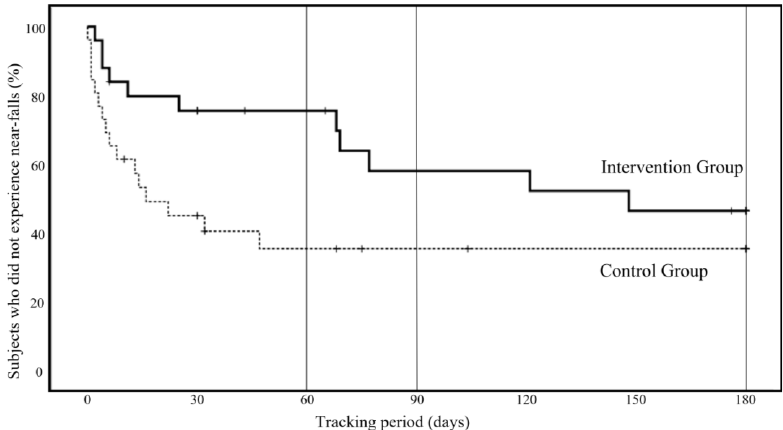
Figure 3. New occurrence of near-falls during the follow-up period (six months), Kaplan – Meier